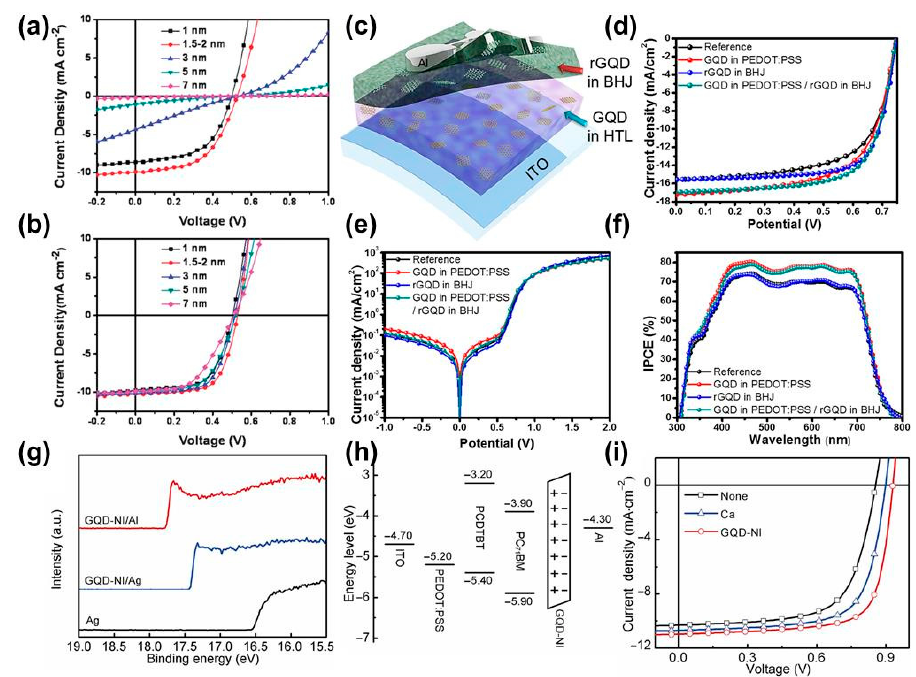
Figure 9. Current density–voltage curves of PSCs using different thicknesses of GO ( a ) or GQDs ( b ) as HTLs. Reproduced with permission [104] . ( c ) Schematic illustration of the device with rGQDs in the BHJ layer and GQDs in HTL (PEDOT: PSS). ( d ) J–V curves, ( e ) dark J–V curves, and ( f ) IPCE of the devices with plain PEDOT: PSS and BHJ (black); PEDOT: PSS with GQDs (red); BHJ with rGQDs (blue); and GQDs and rGQDs added to PEDOT: PSS and BHJ, respectively (green). The concentration ratios of GQDs and rGQDs were 0.4 and 0.02 wt %, respectively. Reproduced with permission [105] . ( g ) Secondary electron cutoff region in ultraviolet photoelectron spectra of GQD-NI interlayer on Al and Ag. ( h ) Energy level diagram of the PSC devices based on the PCDTBT: PC 71 BM active layer with GQD-NI ETLs. ( i ) J–V curves of the PSC devices under AM1.5G illumination with different ETLs using PCDTBT: PC 71 BM as the active layer. Reproduced with permission [106] .